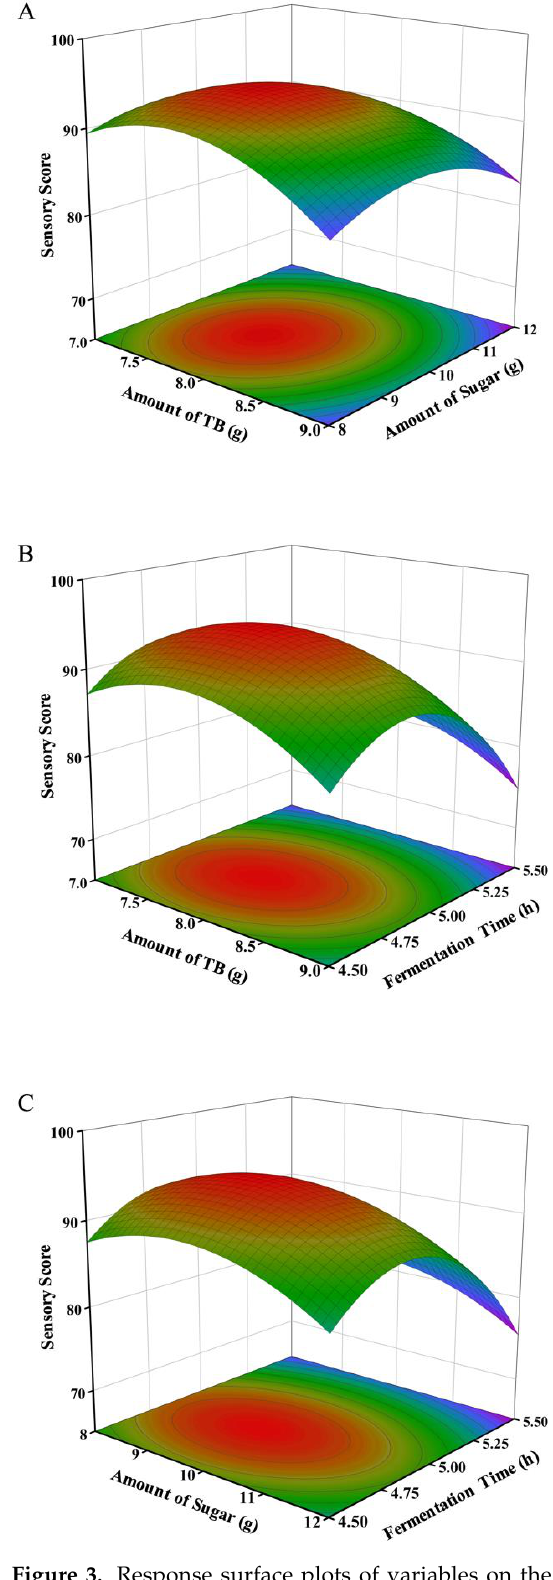
Figure 3. Response surface plots of variables on the sensory score of the yogurt containing TB. ( A ) Interactions between the amount of TB and the amount of sugar. ( B ) Interactions between the amount of TB and the fermentation time. ( C ) Interactions between the amount of sugar and the fermentation time. Red color means the higher sensory score, while purple color means the lower sensory score.